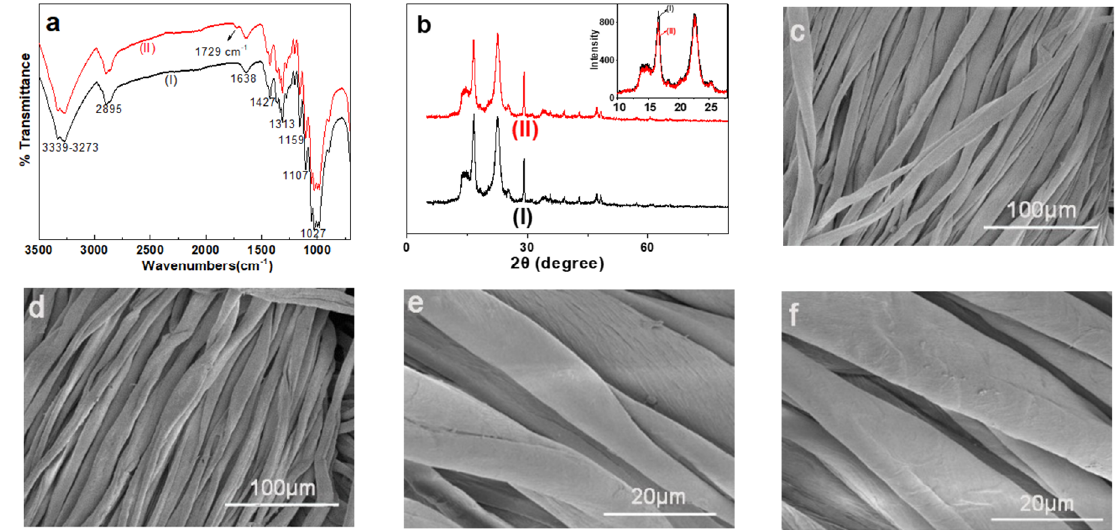
Figure 3. ( a ) ATR-IR spectra of the original (I) and the modified cotton fibers (II); ( b ) X-ray diffraction patterns of the original (I) and the modified cotton fibers (II); ( c , e ) SEM images of the original cotton fibers and ( d , f ) SEM images of the modified cotton fibers (( c , d ) × 1000, ( e , f ) × 5000).